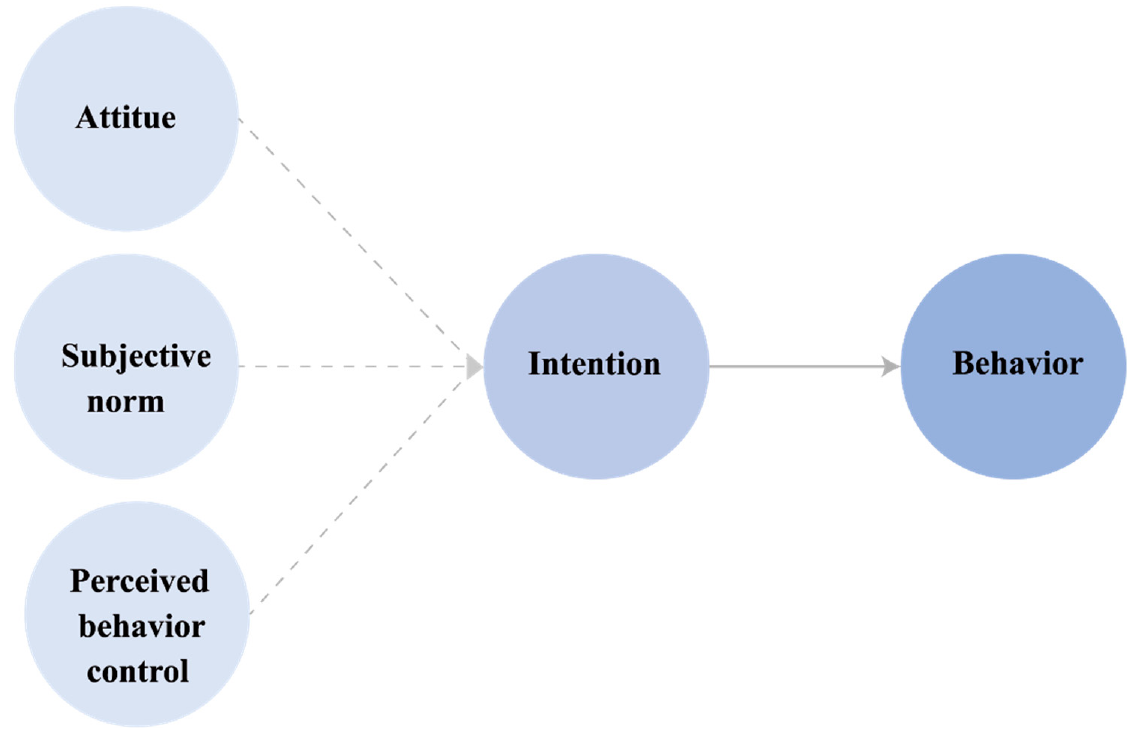
Figure 1. The model of TPB.